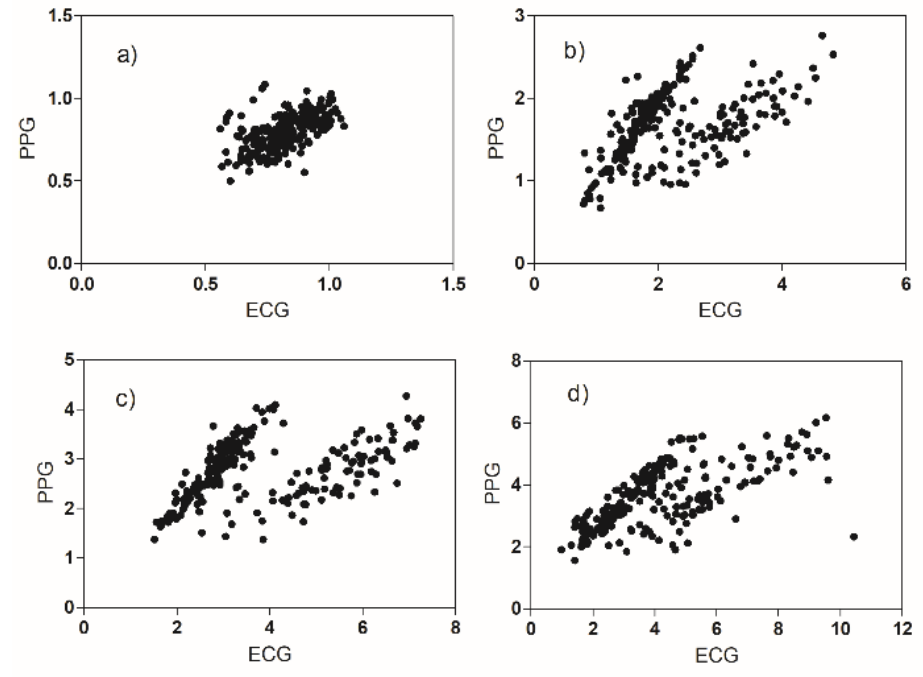
Figure 7. Scatter plots for ( a ) ApEn, ( b ) VLF, ( c ) LF, ( d ) HF values derived from ECG and PPG sensors.